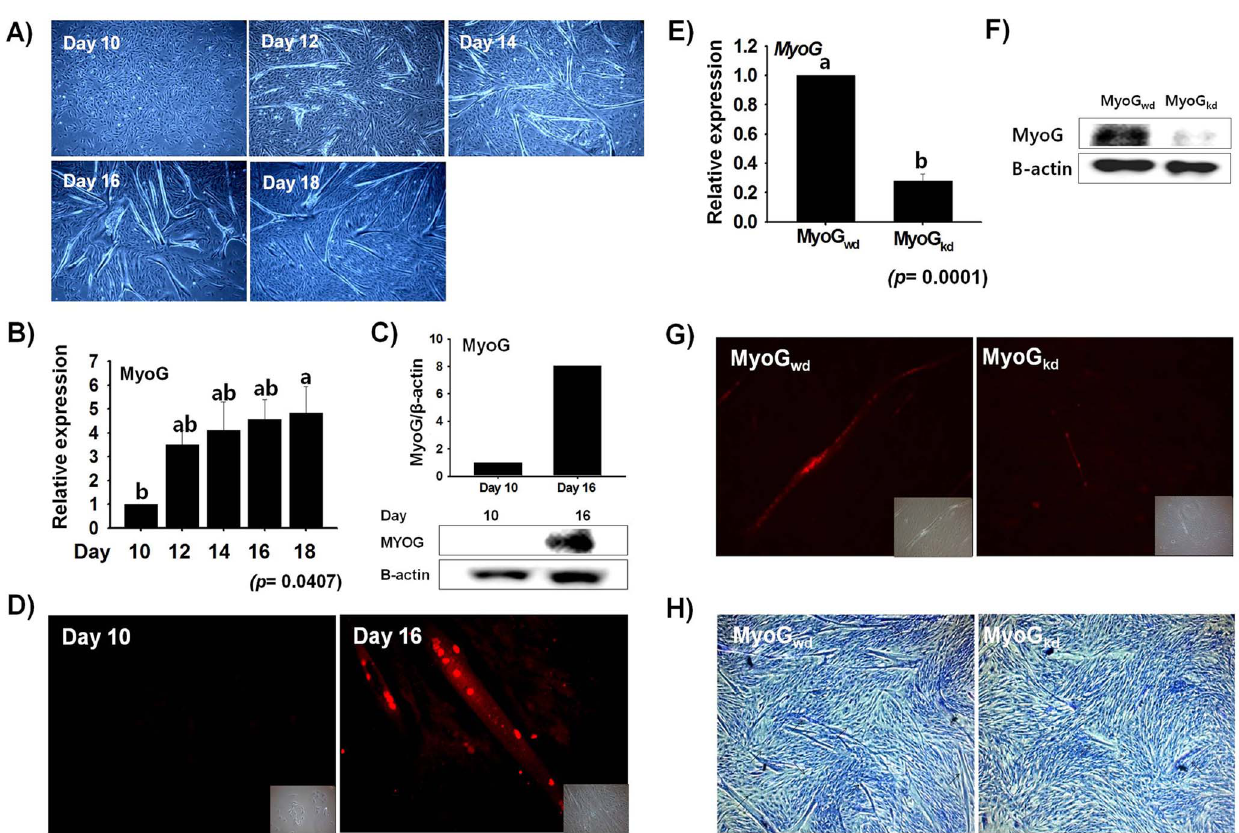
Figure 1. Myogenesis is associated with increased MyoG expression. A ) MSCs proliferation and differentiation in DMEM/10% FBS media. Myotube formation was observed from day 12, reaching a maximum at day 16. B ) MyoG expression from RNA extracted and analyzed by real time RT- PCR. MyoG expression gradually increased with time. C ) MyoG protein expression at Day 10 and Day 16 was determined by Western blot analysis and the protein intensity was measured by using Image J program. MyoG protein in Day 16 cells was significantly higher than in Day 10 cells. D ) Immunocytochemistry analysis of Day 10 and Day 16 cells stained with MyoG antibody. Day 16 showed higher MyoG nuclear expression as compared with Day 10 proliferating cells. E)& F) MyoG mRNA and protein expression of MSCs transfected with MyoG shRNA. MyoG expression was decreased in both RNA and protein level in MyoG kd cells relative to MyoG wd cells. G ) Immunostaining of MyoG wd or MyoG kd cells with MyoG antibody. A significant decrease in nuclear MyoG protein expression was observed in MyoG kd cells. H ) Giemsa staining performed in MyoG wd and MyoG kd cells. Myotube formation was decreased in MyoG kd cells relative to MyoG wd cells. Day 10 and MyoG wd represents control, respectively (mean 6 S.D., n=3). p -value indicates the statistical significance of the data and different letters (a and b) in graph show significant differences among